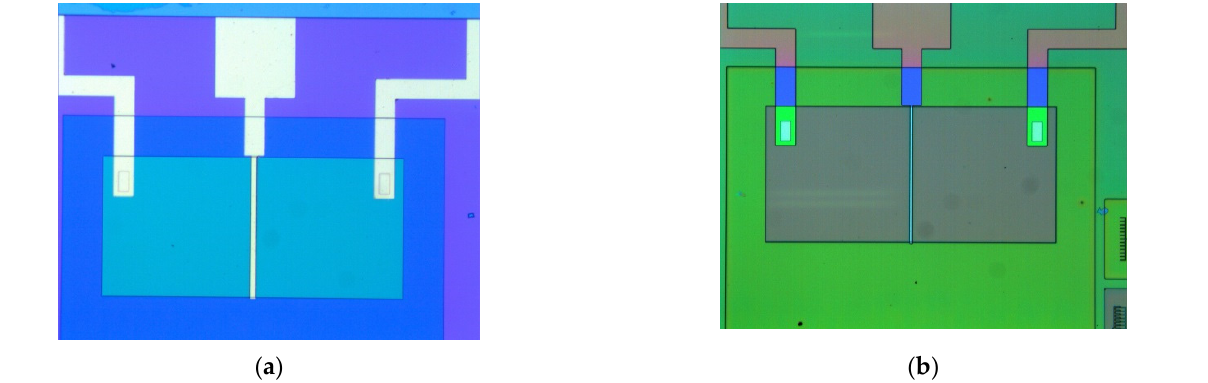
Figure 6. Image of the metallic contacts for the ( a ) reference MOS-FET ( b ) color-coded.